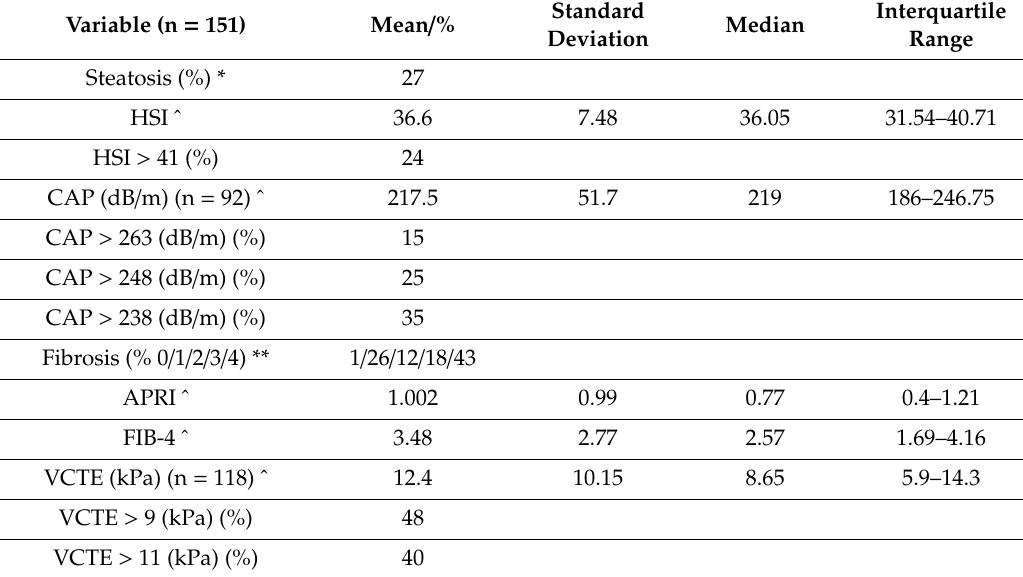
Table 2. Liver disease characteristics of the